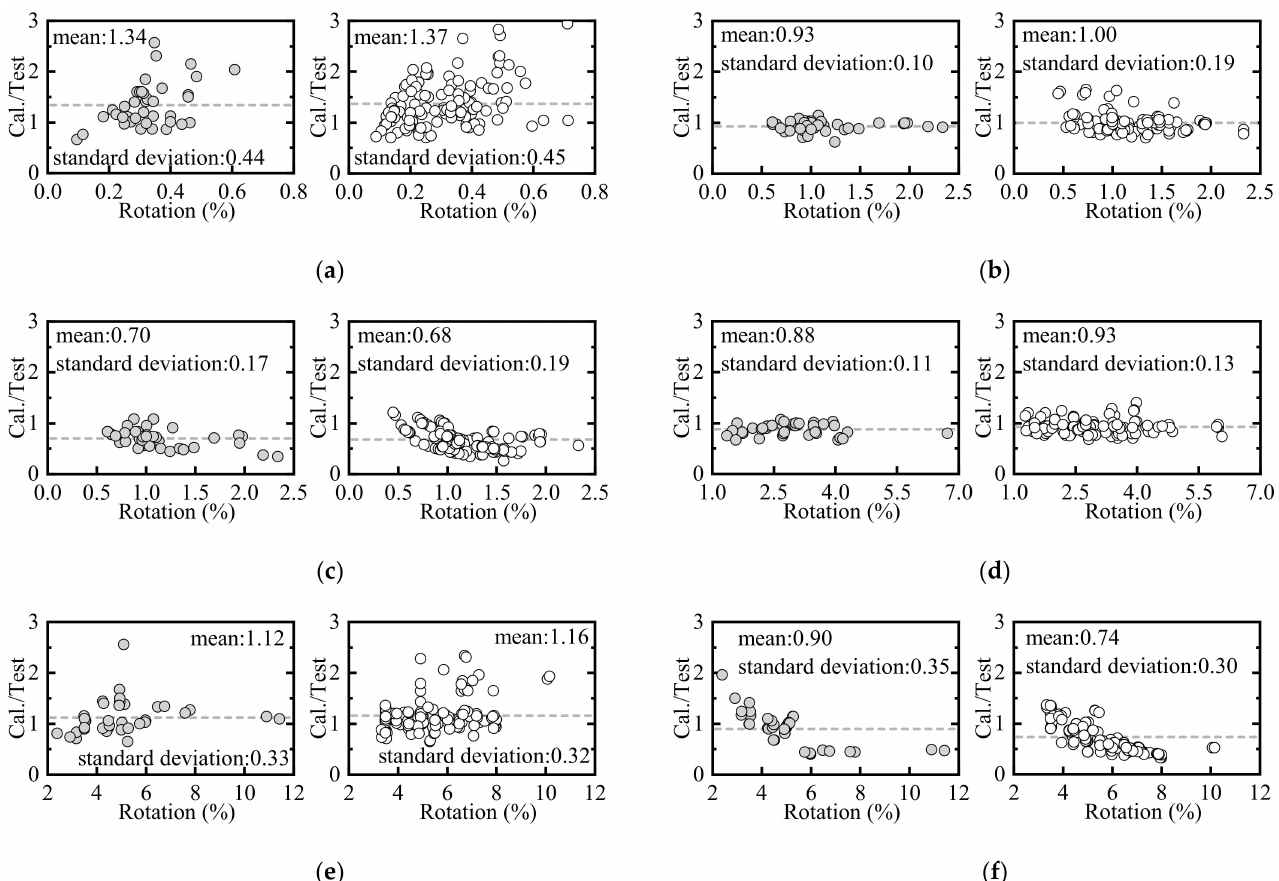
Figure 9. Quantification of each characteristic point of the moment–rotation relationship based on calculation results. Note: The solid points are the results of cast-in situ connections, the hollow points are the results of MPBC connections, and the dashed lines are the mean lines. ( a ) Comparison of initial stiffness; ( b ) Comparison of M y ; ( c ) Comparison of θ y ; ( d ) Comparison of M p ; ( e ) Comparison of M u ; ( f ) Comparison of θ u